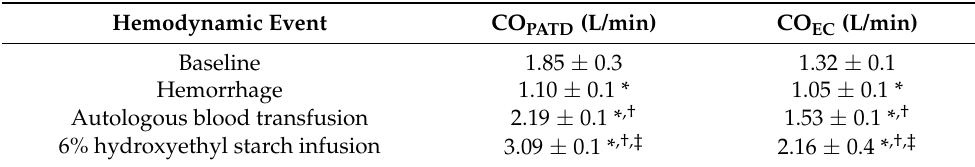
Table 1. Mean ± SD for cardiac output (CO) measurements using electrical cardiometry (CO EC ) and pulmonary artery thermodilution (CO PATD ) recorded in six healthy, isoflurane-anesthetized dogs during four hemodynamic events: (1) baseline; (2) withdrawal of 30 mL/kg blood volume inducing hemorrhage; (3) autologous blood transfusion; and (4) 20 mL/kg 6% hydroxyethyl starch 130/0.4 in 0.9% sodium chloride solution. Since the values for CO PATD and CO EC for the five timepoints under each event are not statistically significant, the mean ± SD values are calculated from the timepoint measurements to represent each event. Hemodynamic Event CO PATD (L/min) CO EC (L/min) Baseline 1.85 ± 0.3 1.32 ± 0.1 Hemorrhage Autologous blood transfusion 6% hydroxyethyl starch infusion 3.09 ± 0.1 * ,†,‡ 2.16 ± 0.4 *